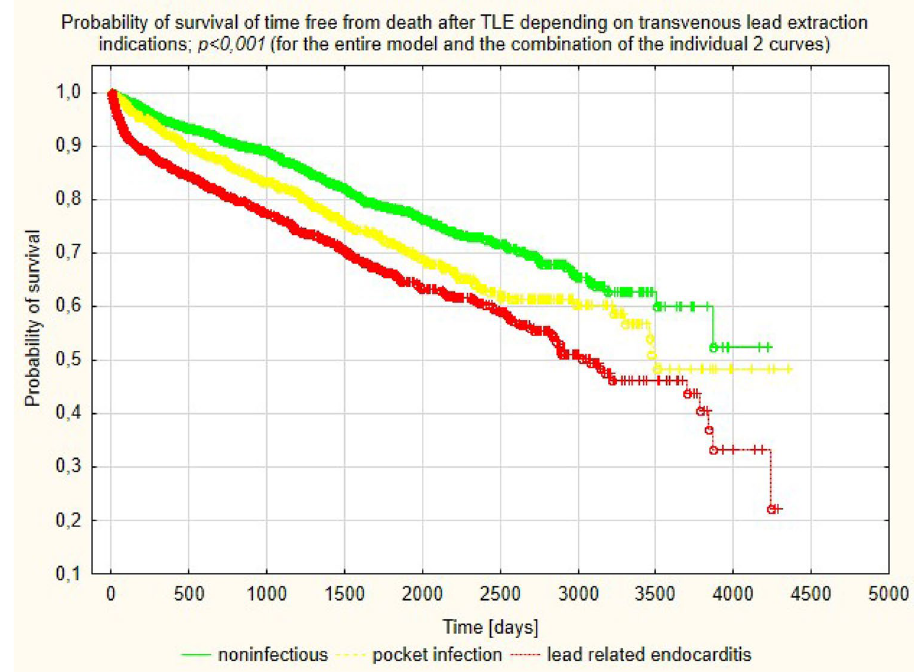
Figure 3. Kaplan–Meier probability of survival depending on indications for transvenous lead extraction